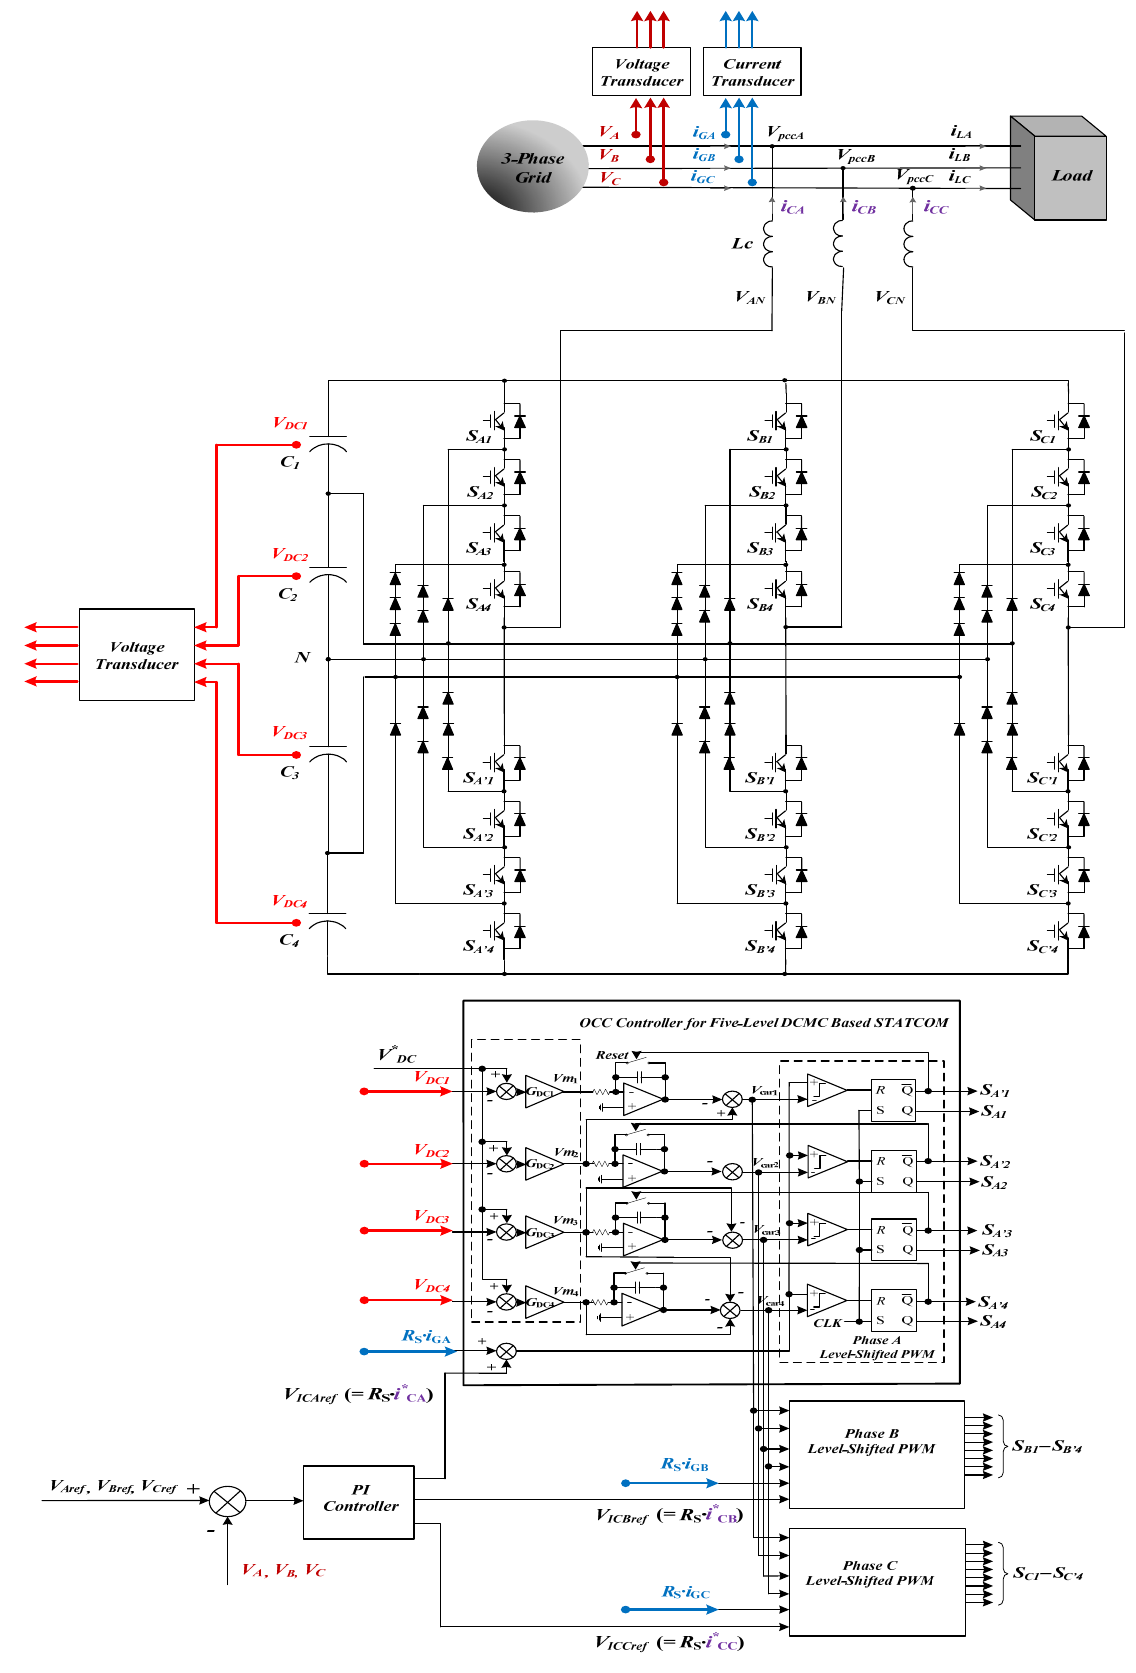
Figure 4. Control diagram of the five-level DCMC-based STATCOM.